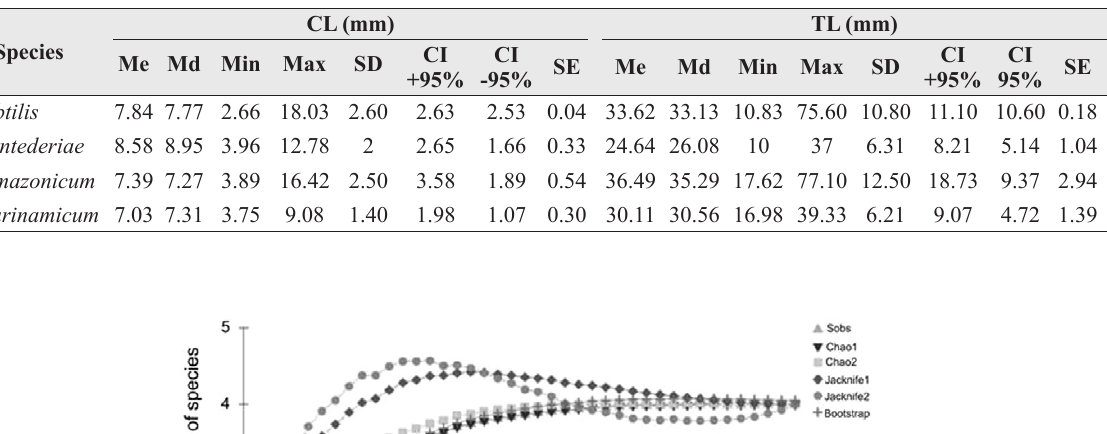
Descriptive statistic of size (Cephalothorax length - CL and Total length - TL) of shrimps from Guarás Island, Curuçá, State of Pará, Brazilian Amazon. (Me = Mean; Md = Median; Min= Minimum; Max = Maximum; SD = Standard deviation; CI = Confidence Interval; and SE = Standard